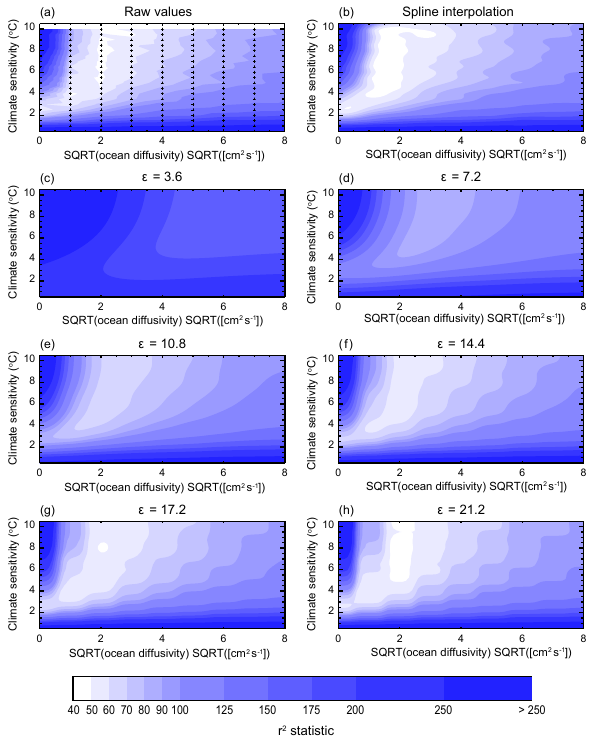
Figure 4. As in Fig. 3, except for (cid:49)r 2 , the difference between r 2 at a given point and the minimum r 2 value in the domain. This represents the difference between r 2 at an arbitrary point and that of the best fit of the model to the